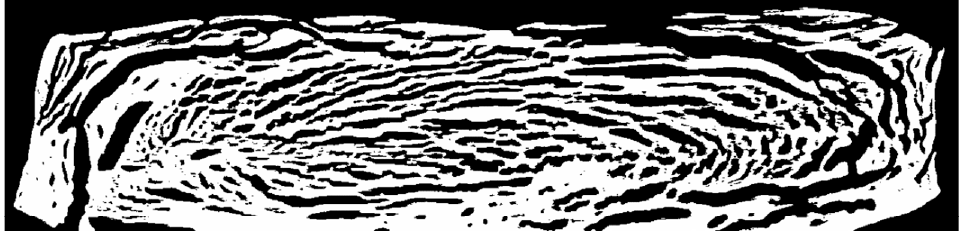
Figure 8. Microstructure of freeze-dried SPI extrudate, obtained with X-ray measurements. Sample was extruded at 50% ( w/w ) moisture content and material temperature of 124 °C before entering the cooling die. Front view is displayed. Flow direction is directed out of the image plane towards the reader.